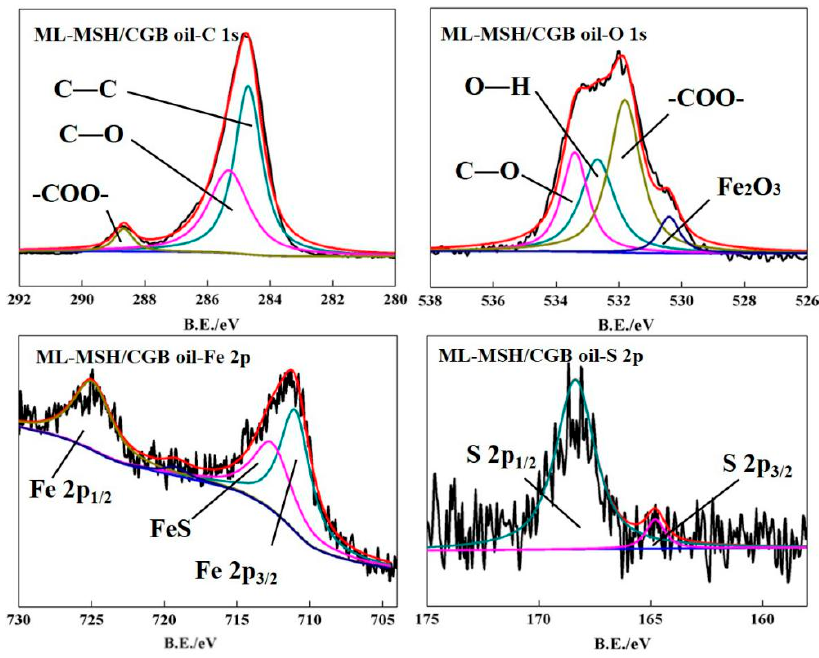
Figure 8. XPS spectrum of steel ball surface after friction test of ML-MSH/CGB oil. Materials 2020 , 13 , x FOR PEER REVIEW